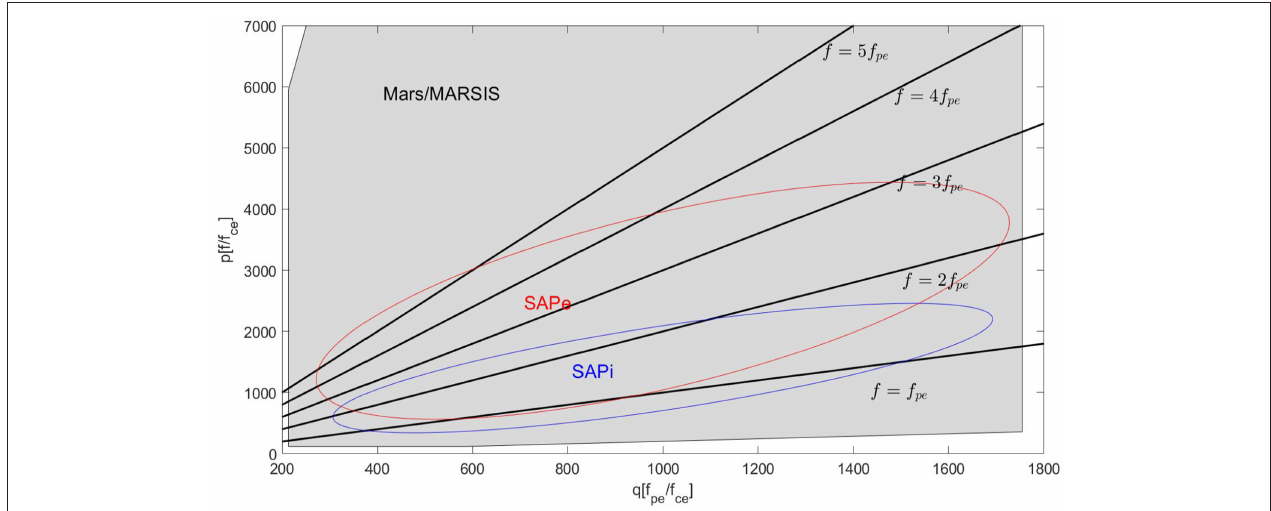
FIGURE 4 | Presentation of SAP observations by MEX on the p − q diagram. The gray area shows the range of the p − q parameters obtained for typical conditions of the Martian ionosphere (summarized in Table 3 ) and MARSIS sounding characteristics (summarized in Table 2 ). The areas encircled by blue and red lines indicate regions where SAP ions and electrons were